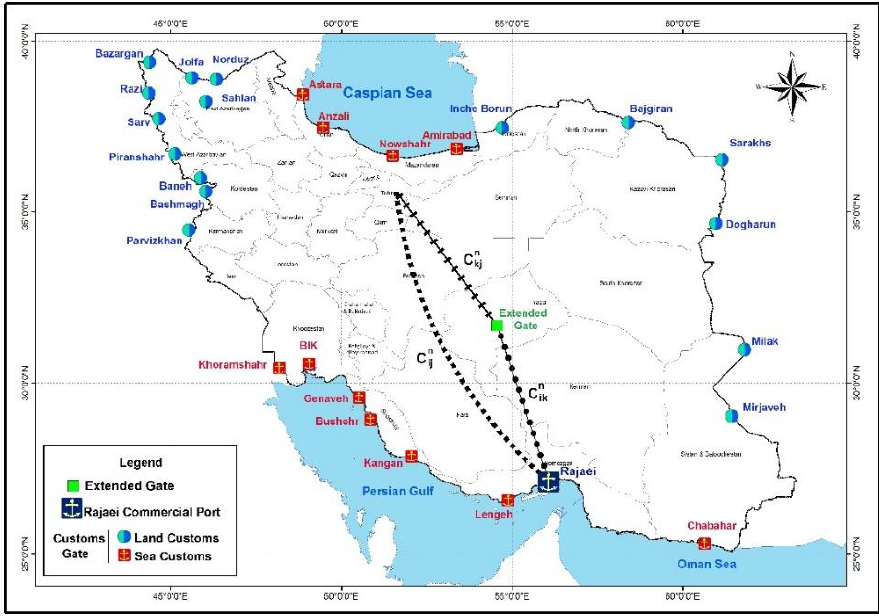
Figure 4. Sample of direct/via extended gate transportation costs